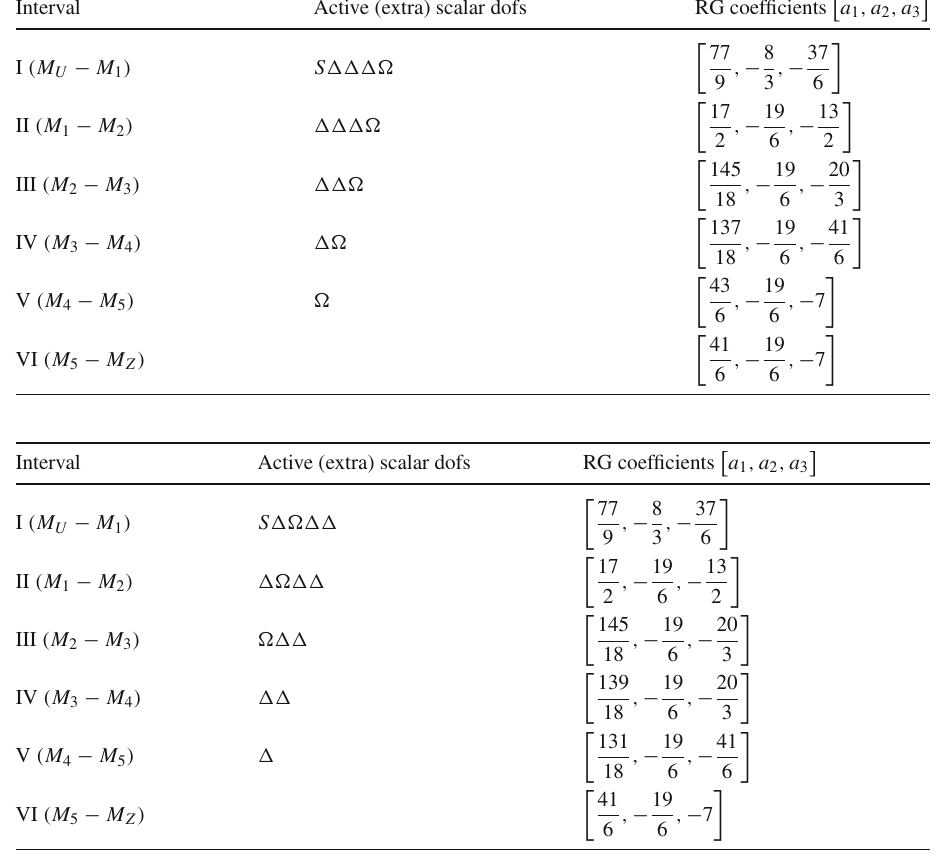
Table 4 The distribution of the new scalars among the energy intervals and the corresponding RG coefficients for